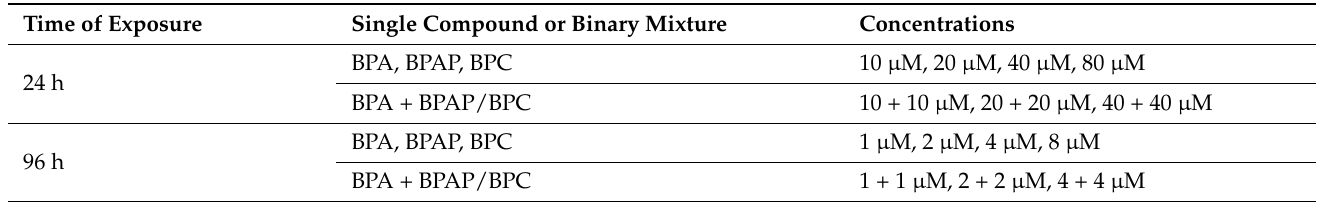
Table 2. Treatment conditions and selected concentration for the experiments. Time of Exposure Single Compound or Binary Mixture